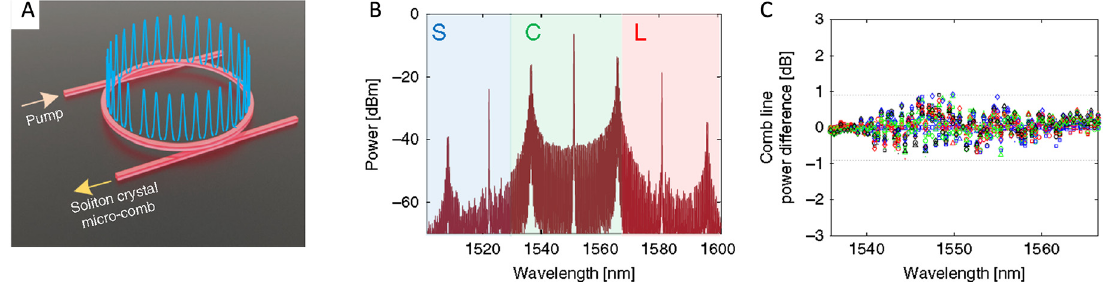
Figure 11: (A) Illustration of soliton crystal micro-comb state, which is a single temporal pulse defect across the ring. (B) Optical spectrum of the soliton crystal micro-comb. (C) The comb line power difference for 10 independent soliton crystal generation instances is within ± 0.9 dB, indicating reliable generation of the soliton crystal micro-comb. Reprinted with the permission from Ref. [92], Copyright 2020, Springer